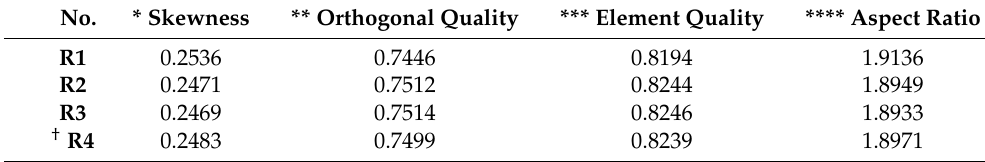
Table 1. Average values of mesh quality factors for various rotary reactor configurations. No. * Skewness ** Orthogonal Quality *** Element Quality **** Aspect Ratio R1 0.2536 0.7446 0.8194 1.9136 R2 0.2471 0.7512 0.8244 1.8949 R3 0.2469 0.7514 0.8246 1.8933 † R4 0.2483 0.7499 0.8239